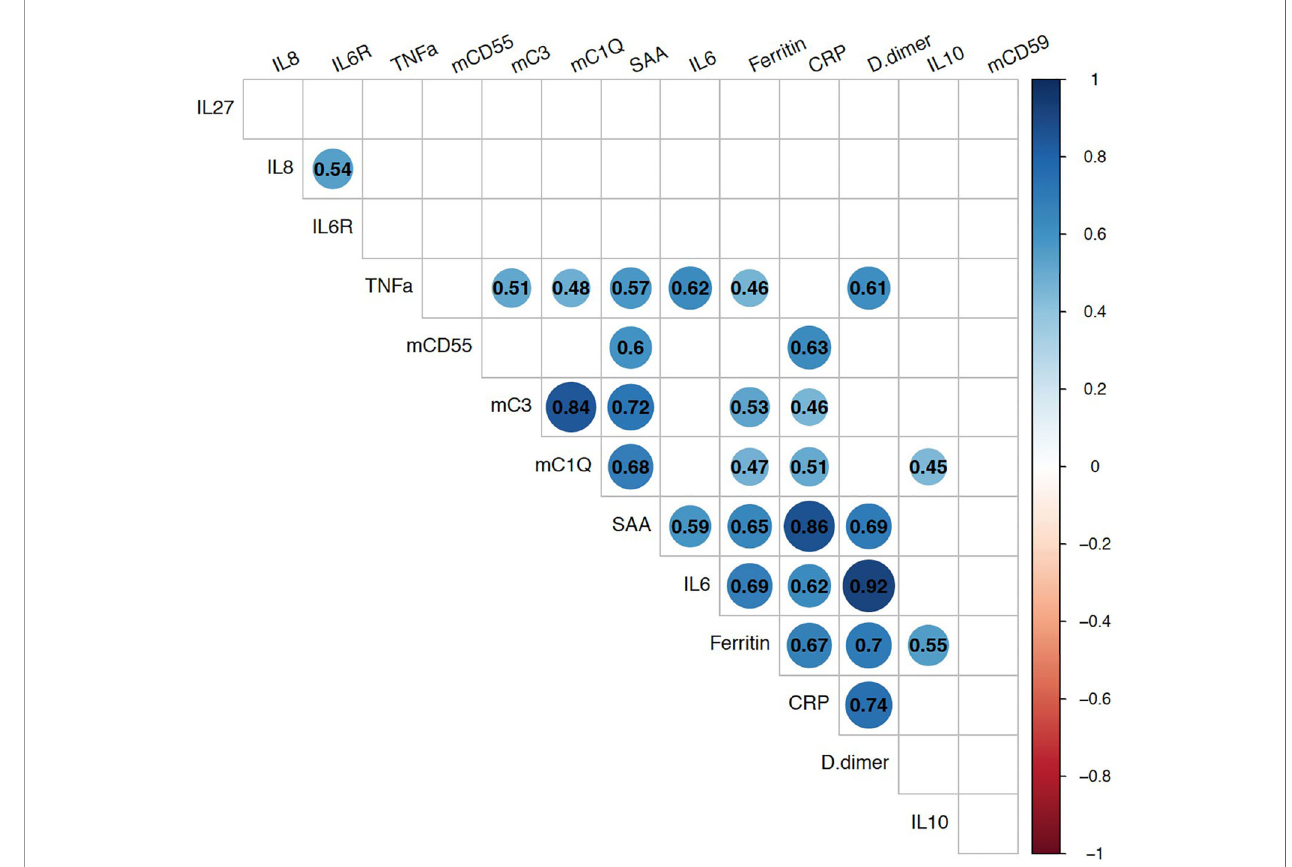
FIGURE 3 | Relationship between monocyte bound complement markers and circulating systemic in fl ammatory biomarkers during acute COVID-19. Multi- parameter Spearman ’ s correlation analysis of monocyte membrane-bound markers (mC1q, mC3, mCD55, mCD59) and plasma circulating biomarkers from COVID- 19 patients (statistically signi fi cant associations with p < 0.05 are highlighted with correlation coef fi cients in colored